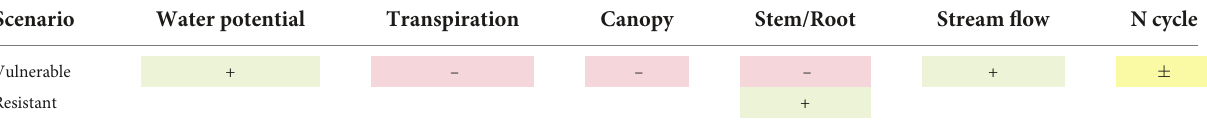
TABLE 6 Overview of changes in ecosystem modeling outcomes using Paleo -BGC + (with sapwood dysfunction) as compared to the previously published version of the model. Scenario